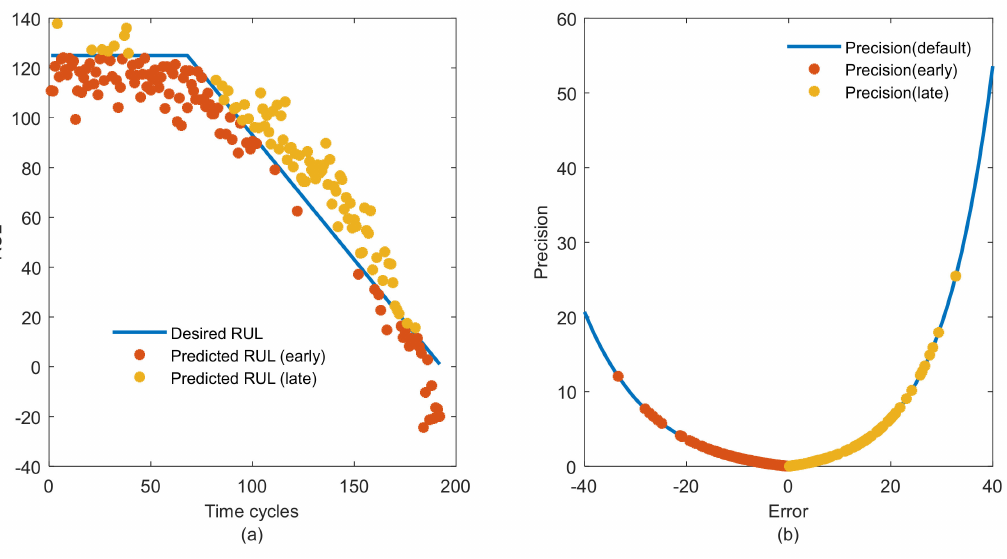
Figure 8. Applying PHM 2008 accuracy analysis formula on RUL curve fit: ( a ) RUL curve fit with ML linear model; ( b ) Predictions distributions according to PHM 2008 accuracy